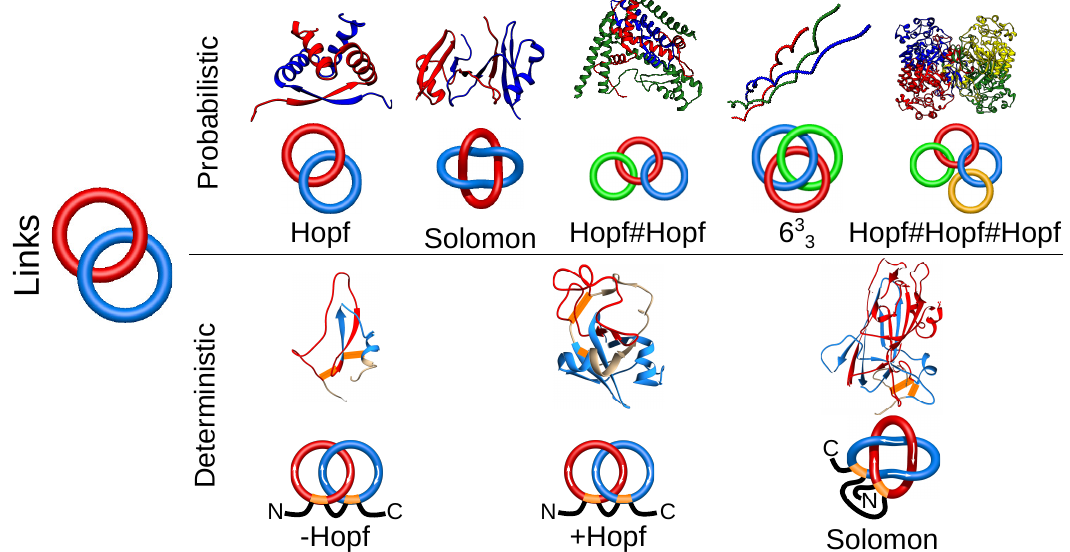
Figure 4. Different types of linked topologies identified in proteins to date. In the top row, the probabilistic links formed by several chains are presented. In the bottom row, deterministic links formed by covalent (disulfide) loops in one chain are shown. For each link type, an exemplary structure along with a scheme of its topology is presented. PDB IDs of the structures of probabilistic links (left to right): 1arr, 2hj1, 5kdm, 3ipn, 2a5h; deterministic links (left to right): 2lfk, 2kqa, 4asl.